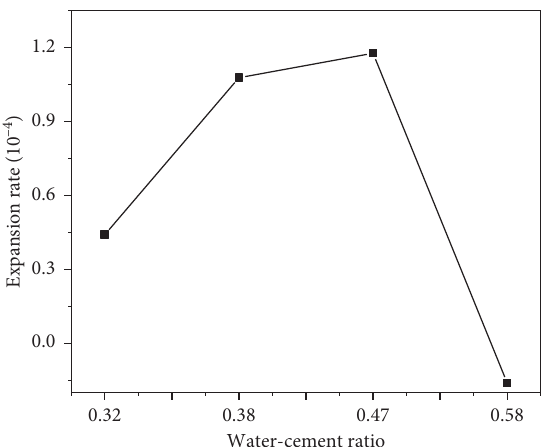
Figure 17: The impact of the replacement particle size of steel slag sand on the expansion rate of the